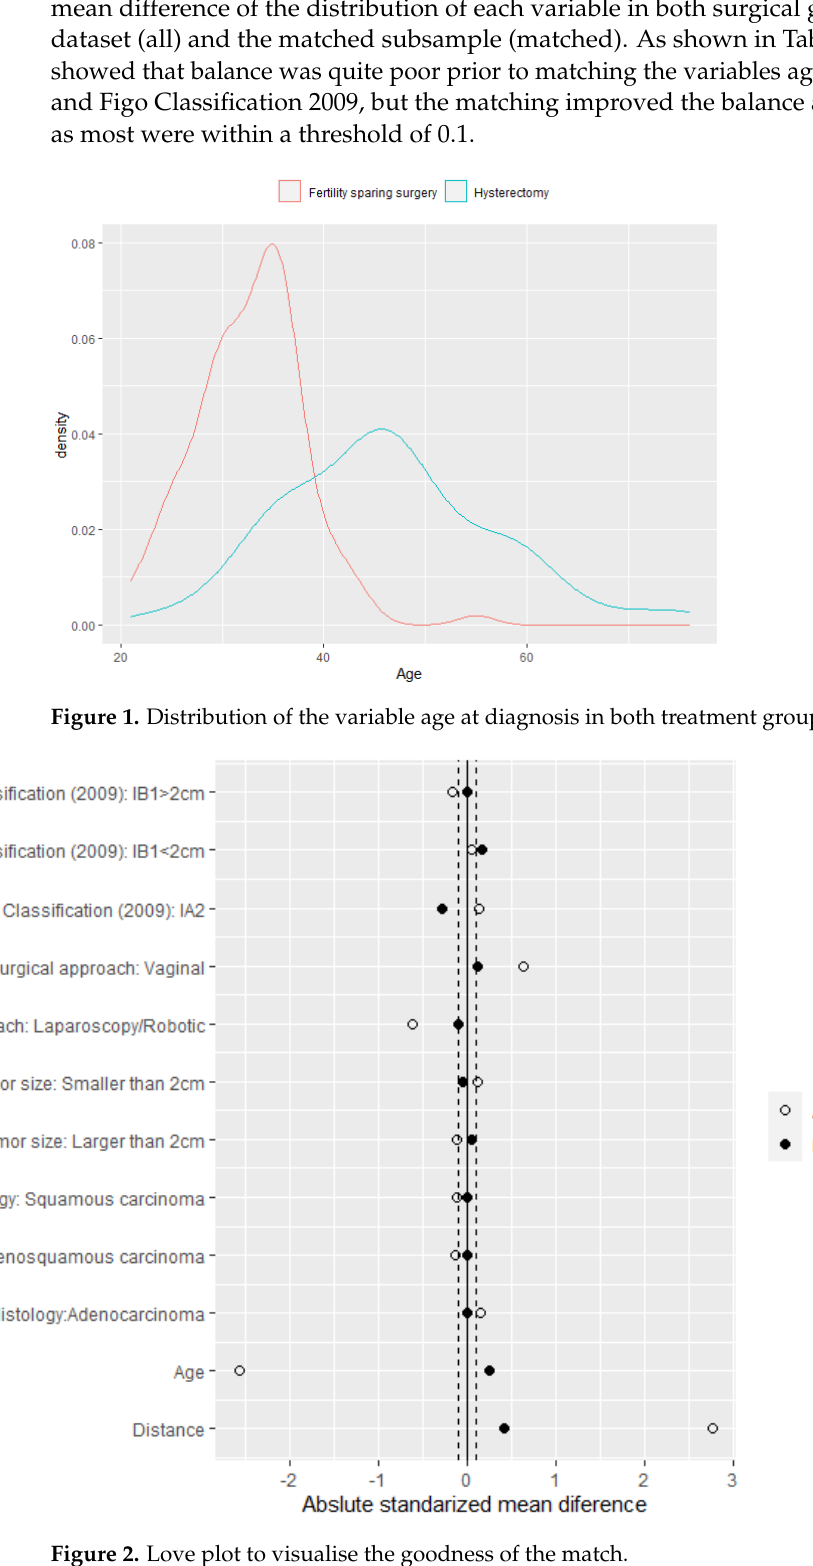
Table 3. Clinicopathological characteristics of the matched series. Matched Sub- sample n = 76